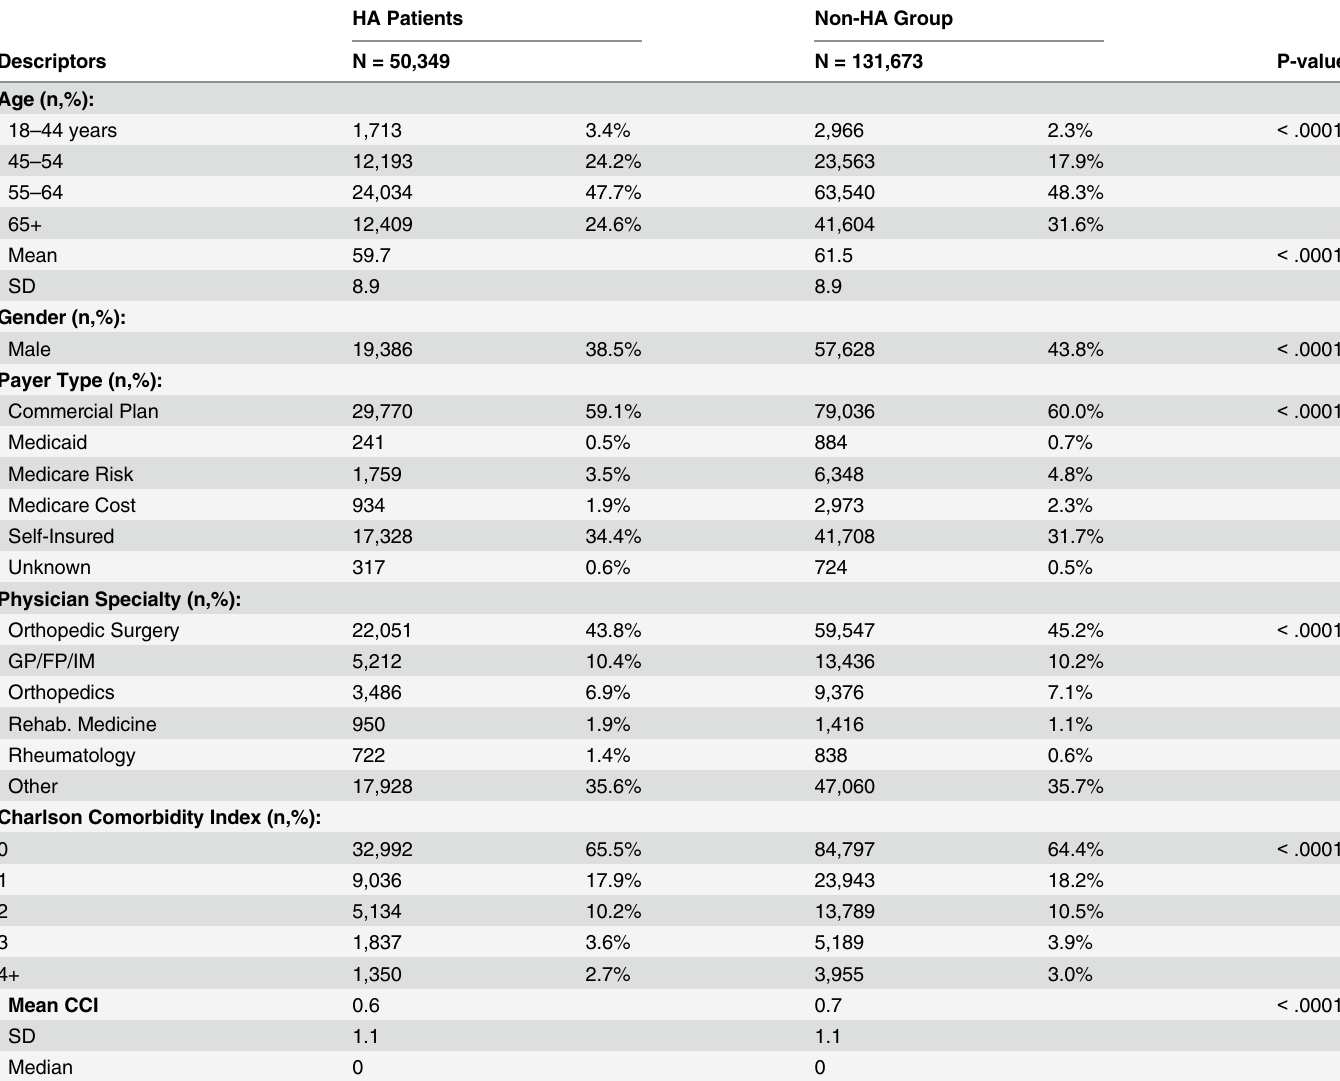
Table 1. Demographic descriptors of HA Users and HA Non-users. The P value shown is for a χ 2 evaluation of all demographic descriptors in the cate- gory. The heading “ GP/FP/IM ” includes physicians in General Practice, Family Practice, and Internal Medicine. HA